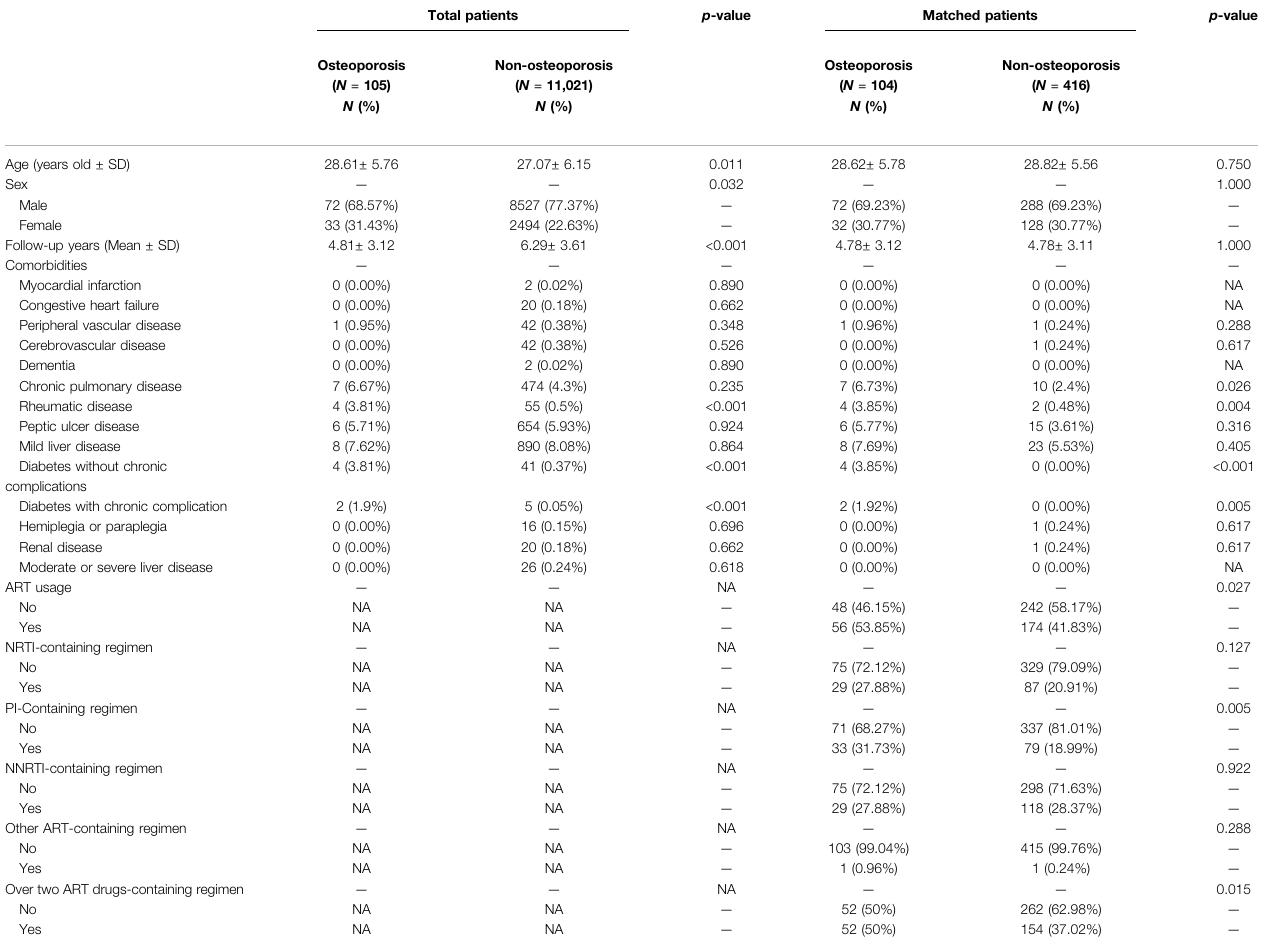
TABLE 1 | Basic characteristics of HIV-infected patients in